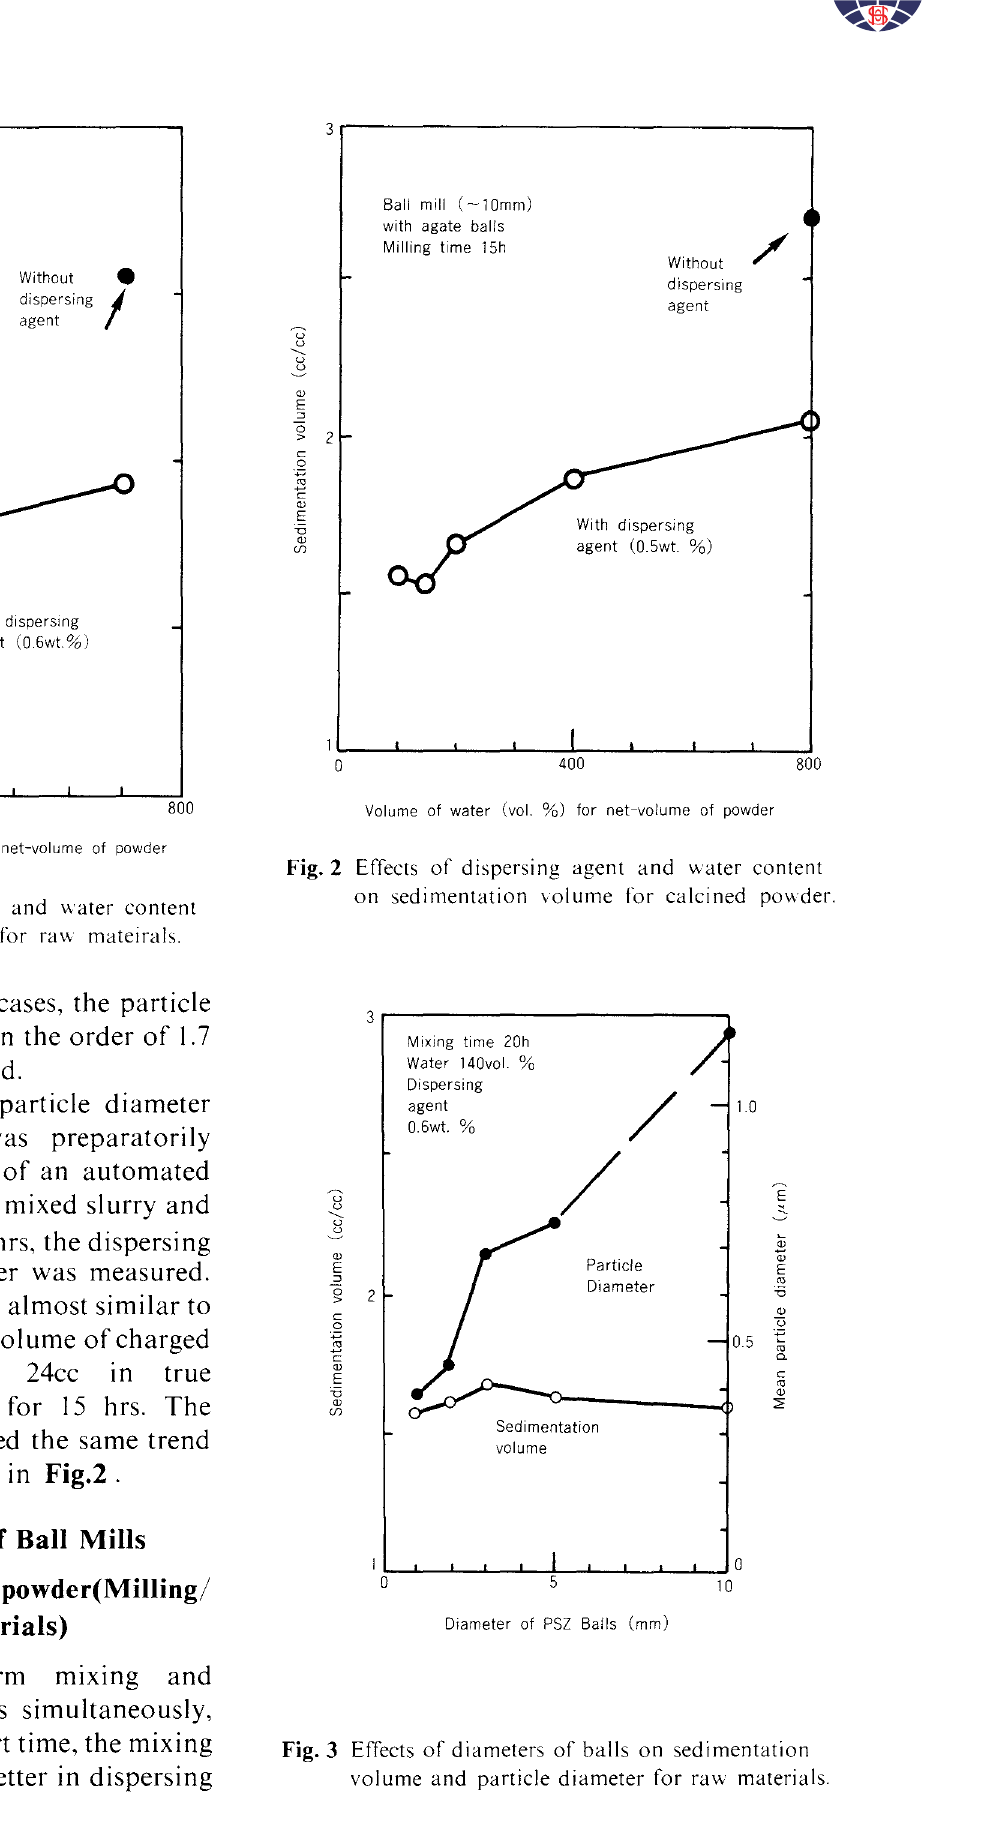
Fig. 3 Effects of diameters of balls on sedimentation volume and particle diameter for raw